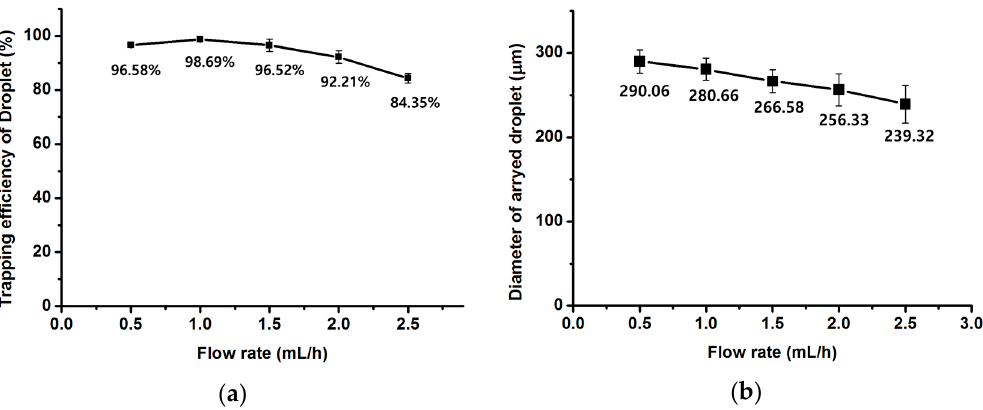
Figure 4. Trapping efficiency ( a ) and diameter ( b ) of water sample array according to flow rates.